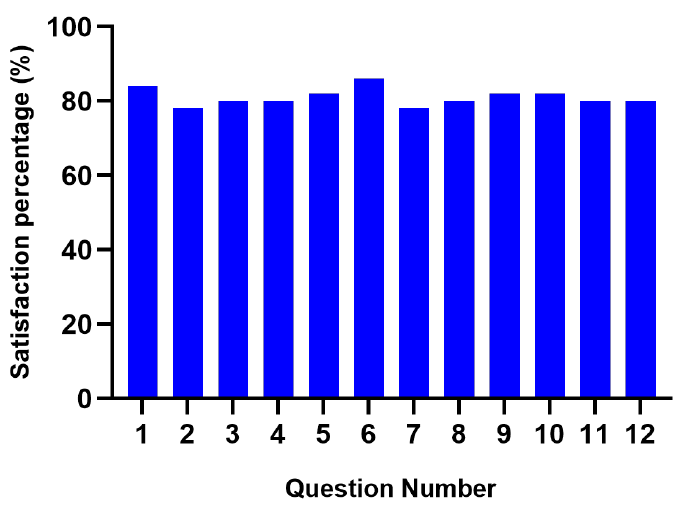
Figure 5. Results of the satisfaction survey displayed through satisfaction percentages according to each question performed, where 100 corresponds to “very satisfied” and 0 corresponds to “very unsatisfied”.